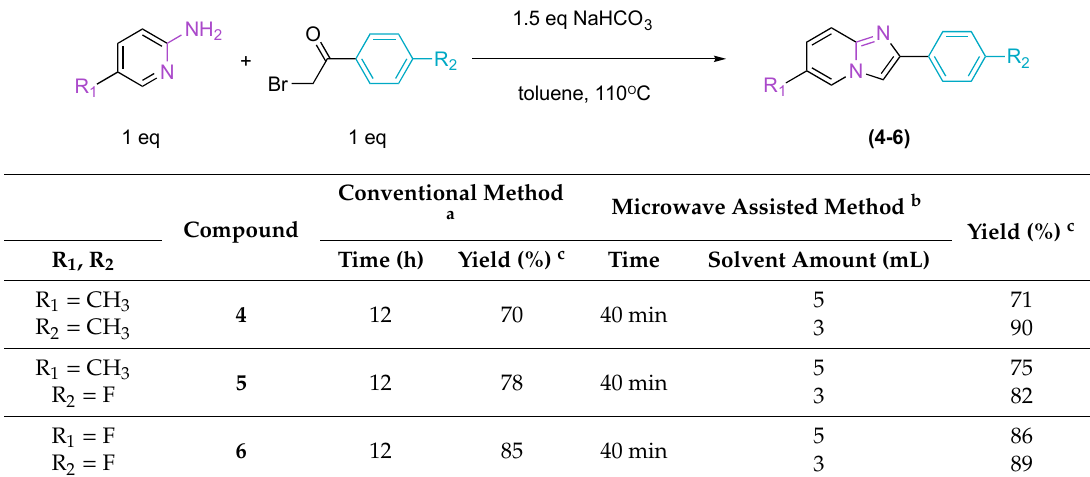
Table 2. Comparison of the performance of condensations between 2-aminopyridines and α - bromoacetophenones under microwave radiation versus traditional oil-bath heating (Step 1).